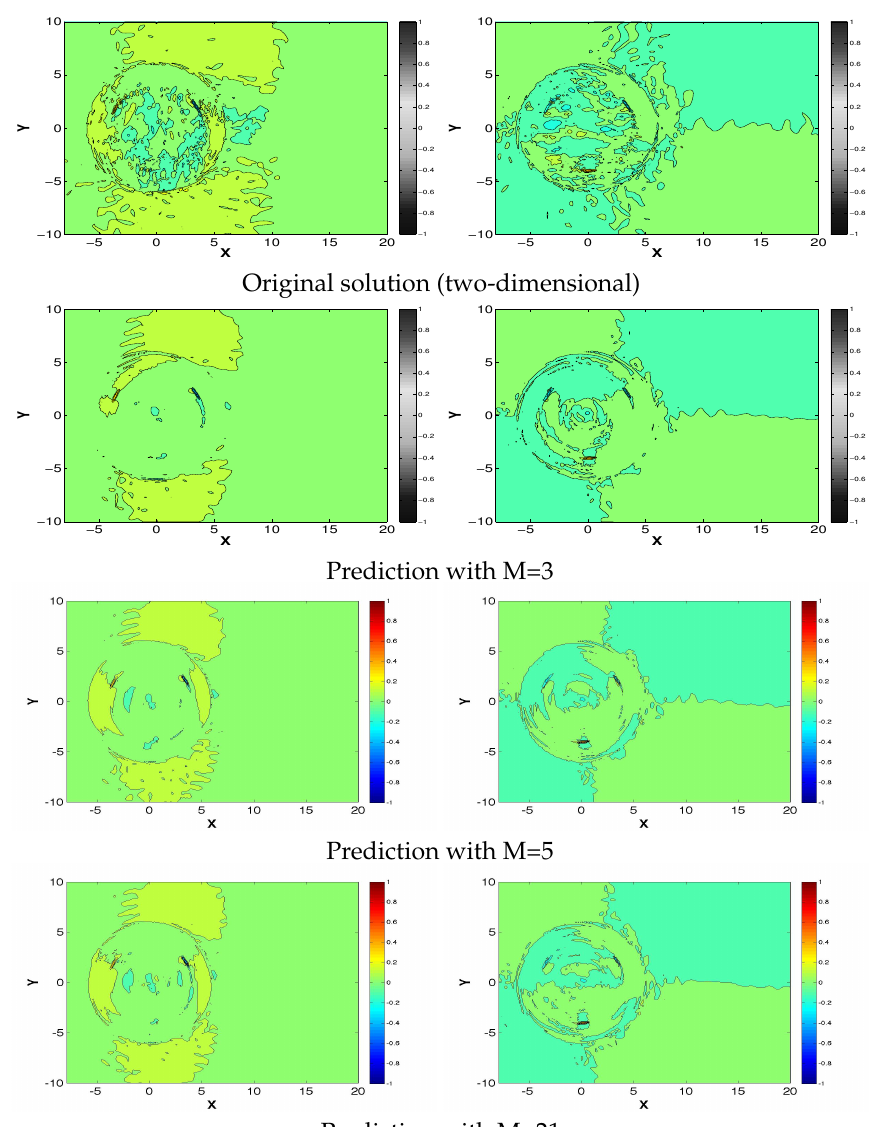
Figure 11. Counterpart of Figure 6 in the three-blades turbine applying HODMD in 196 snapshots starting at time 80.1